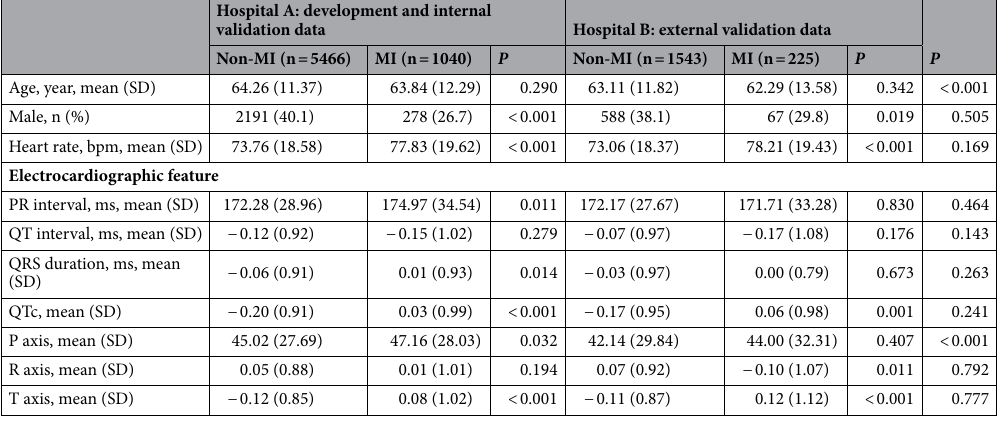
Table 1. Baseline